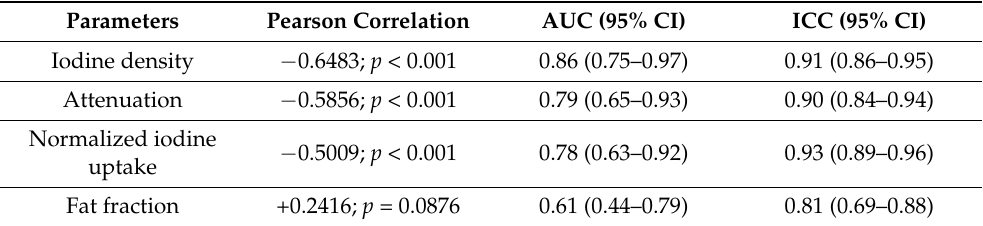
Table 3. Correlation with acute pancreatitis severity and diagnostic performance to discriminate between mild/moderate acute pancreatitis and severe acute